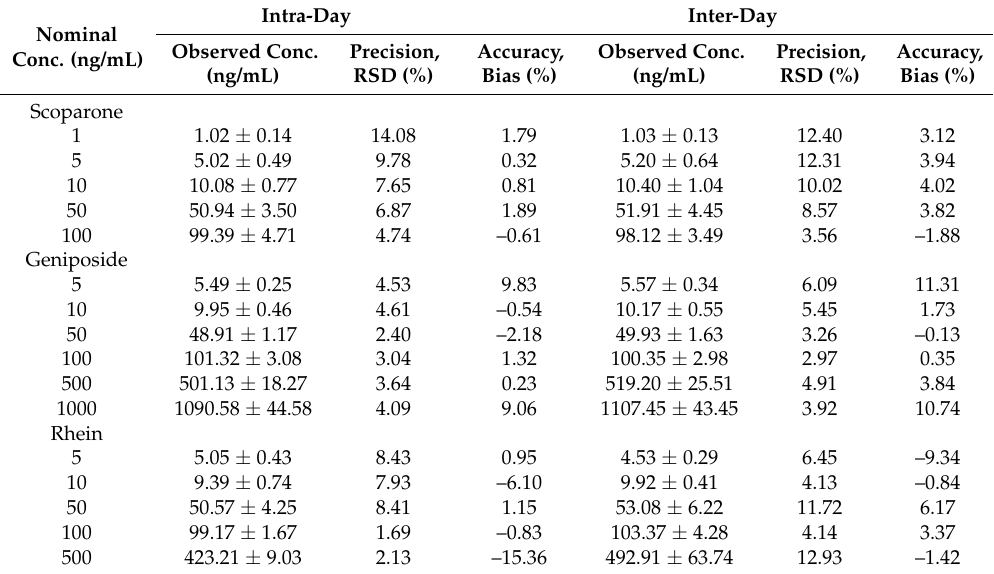
Table 3. Intra- and inter-day precision and accuracy for the determinations for the three compounds. Nominal Conc.